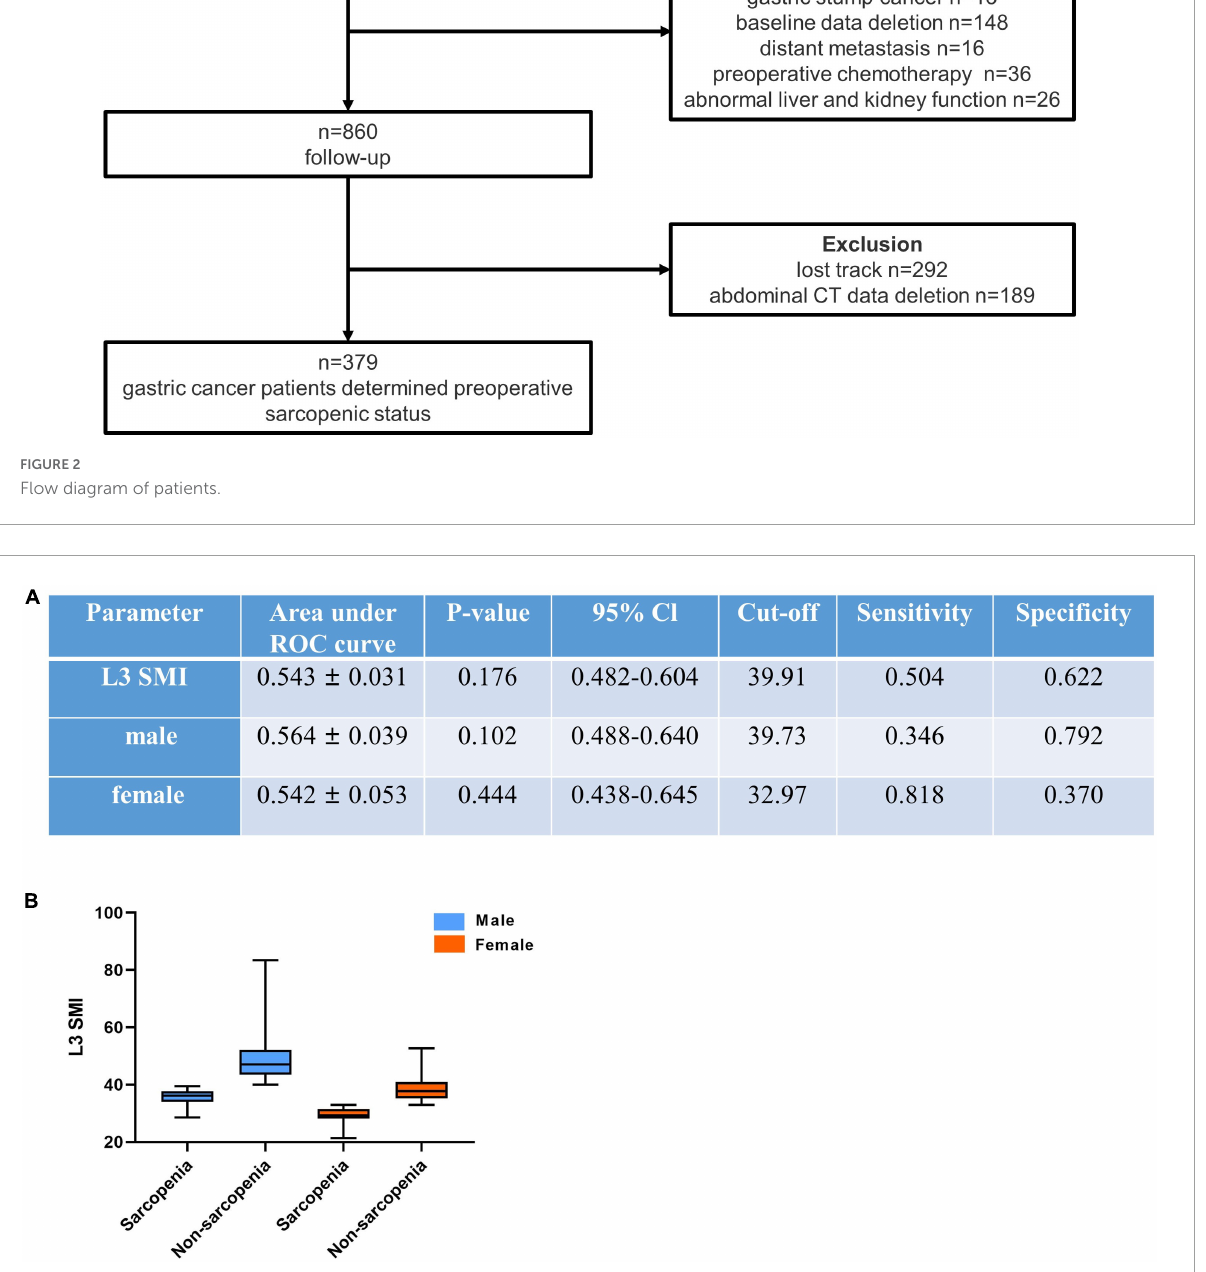
p = 0.000), lymph node metastasis (N2–3) (HR, 3.091; 95% CI, 2.165–4.313; p = 0.000), poor differentiation (HR, 1.635; 95% CI, 1.079–2.479; p = 0.045), sarcopenia (men)